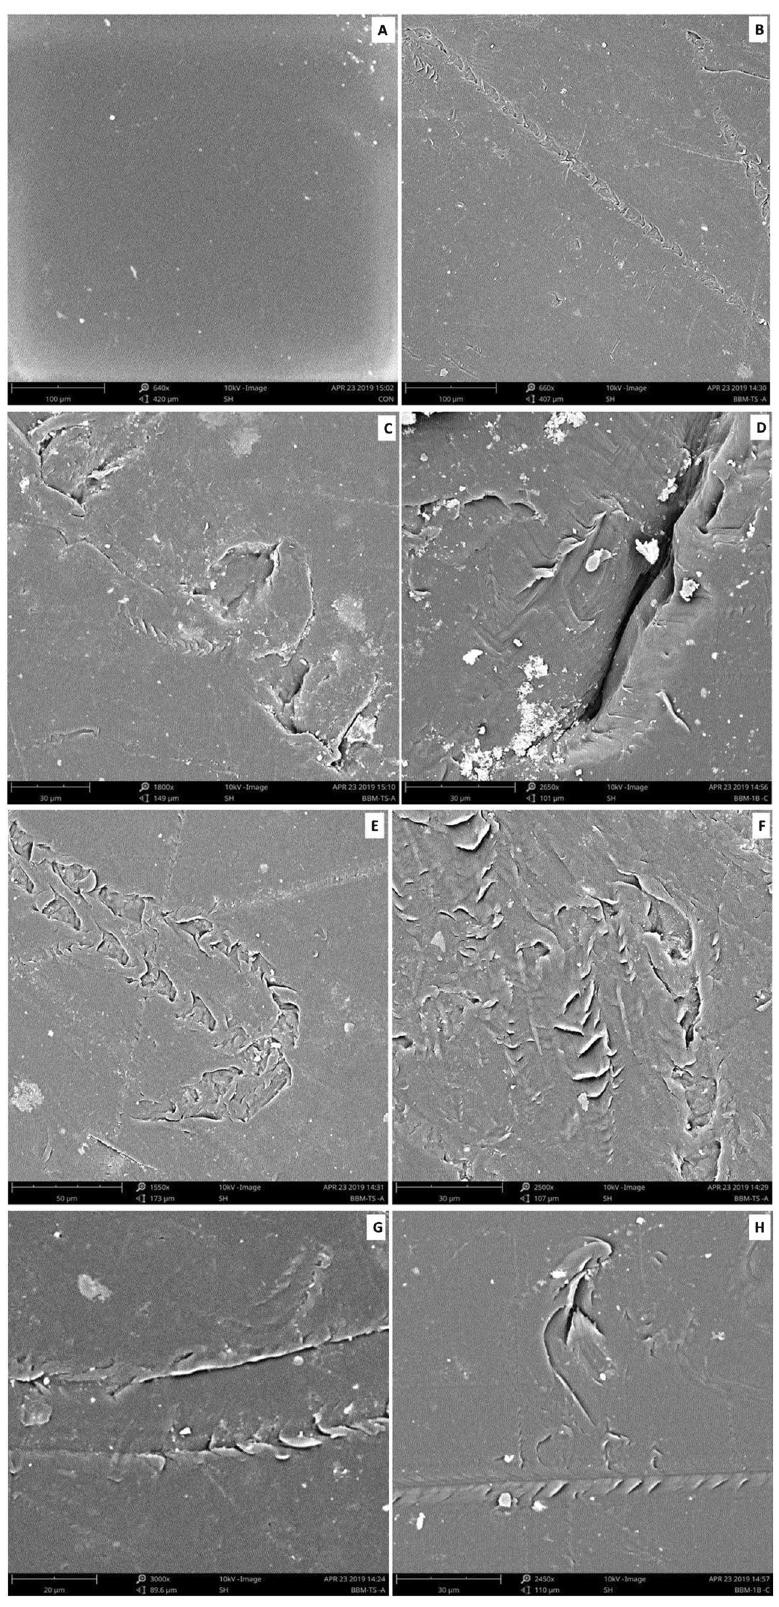
Figure 17. Scanning electron microscopical view of control and microalga treated LDPE sheet. ( A ) SEM image of untreated control LDPE sheet; ( B – H ) SEM images of U. africanum treated LDPE sheet showing erosions, abrasions, ridges and grooves on the surface of LDPE